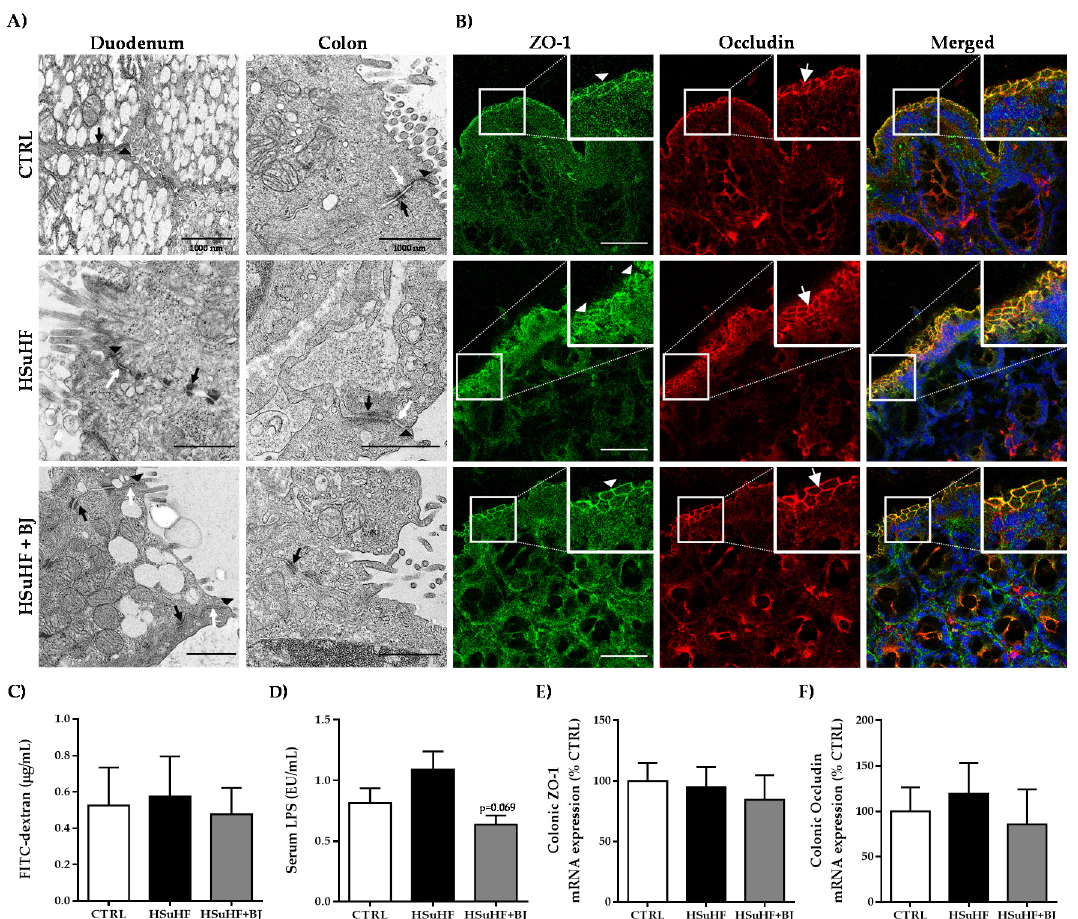
Figure 3. Impact of BJ on gut barrier structure and intestinal permeability. Representative TEM images of ultrastructural analysis of tight junctions (black arrowhead), adherens junctions (white arrow), and desmosomes (black arrow) in duodenum and colon sections ( A ) (scale bar: 1000 nm). Representative confocal images of immunohistochemistry staining of ZO-1 (white arrowhead) and occludin (white arrow) in colon sections ( B ) (scale bar: 50 µ m). Serum FITC-dextran concentrations ( C ), serum LPS levels ( D ), colonic mRNA expression of ZO-1 ( E ), and occludin ( F ) in CTRL, HSuHF, and HSuHF + BJ groups. Results are expressed as the mean ± SEM. ( n = 8–10/group); p = 0.069 vs. HSuHF group. CTRL: control. HSuHF: high sucrose / high-fat. BJ: blueberry juice.